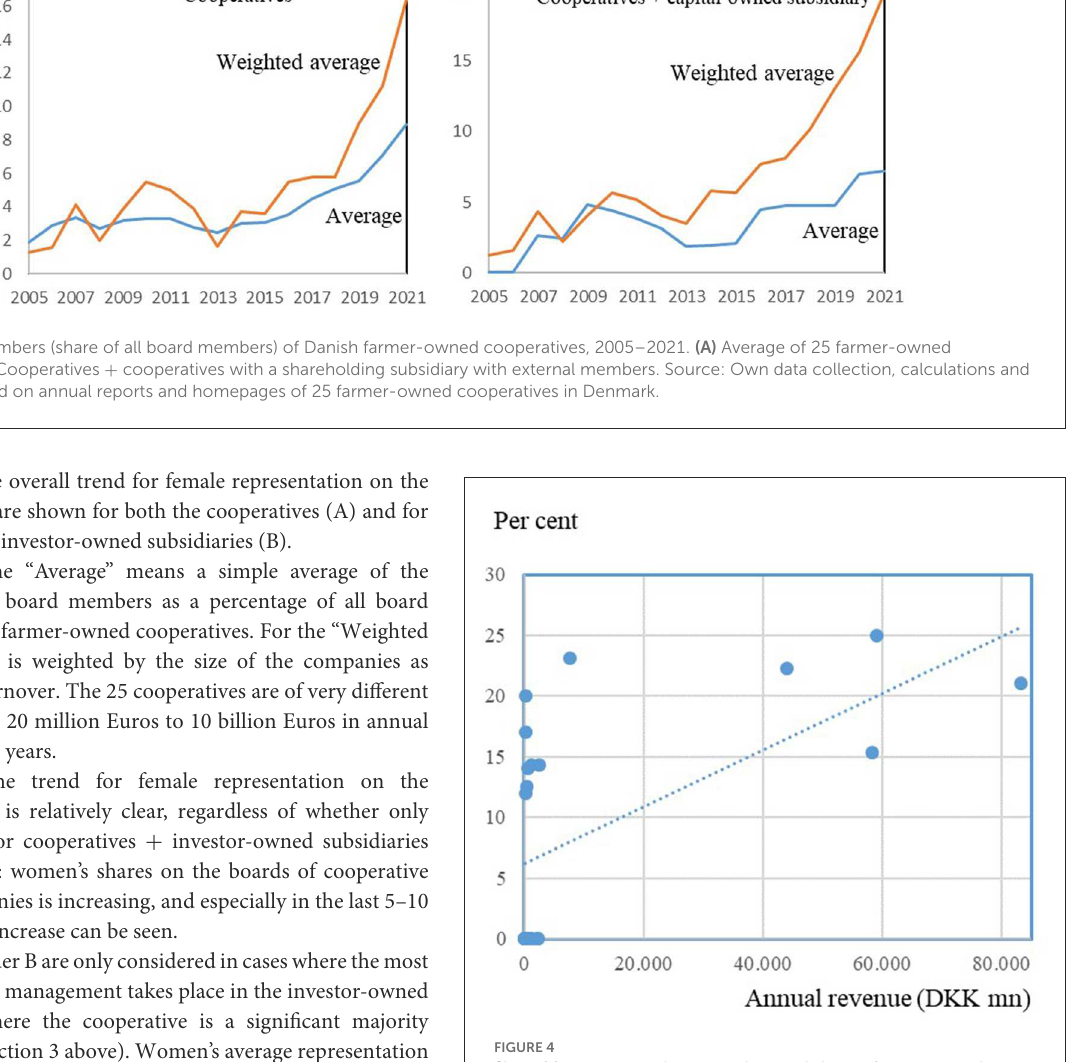
FIGURE4 Size of farmer-owned cooperatives and share of women on the boards. Source: Own data collection, calculations and presentation based on annual reports and homepages of 25 farmer-owned cooperatives in